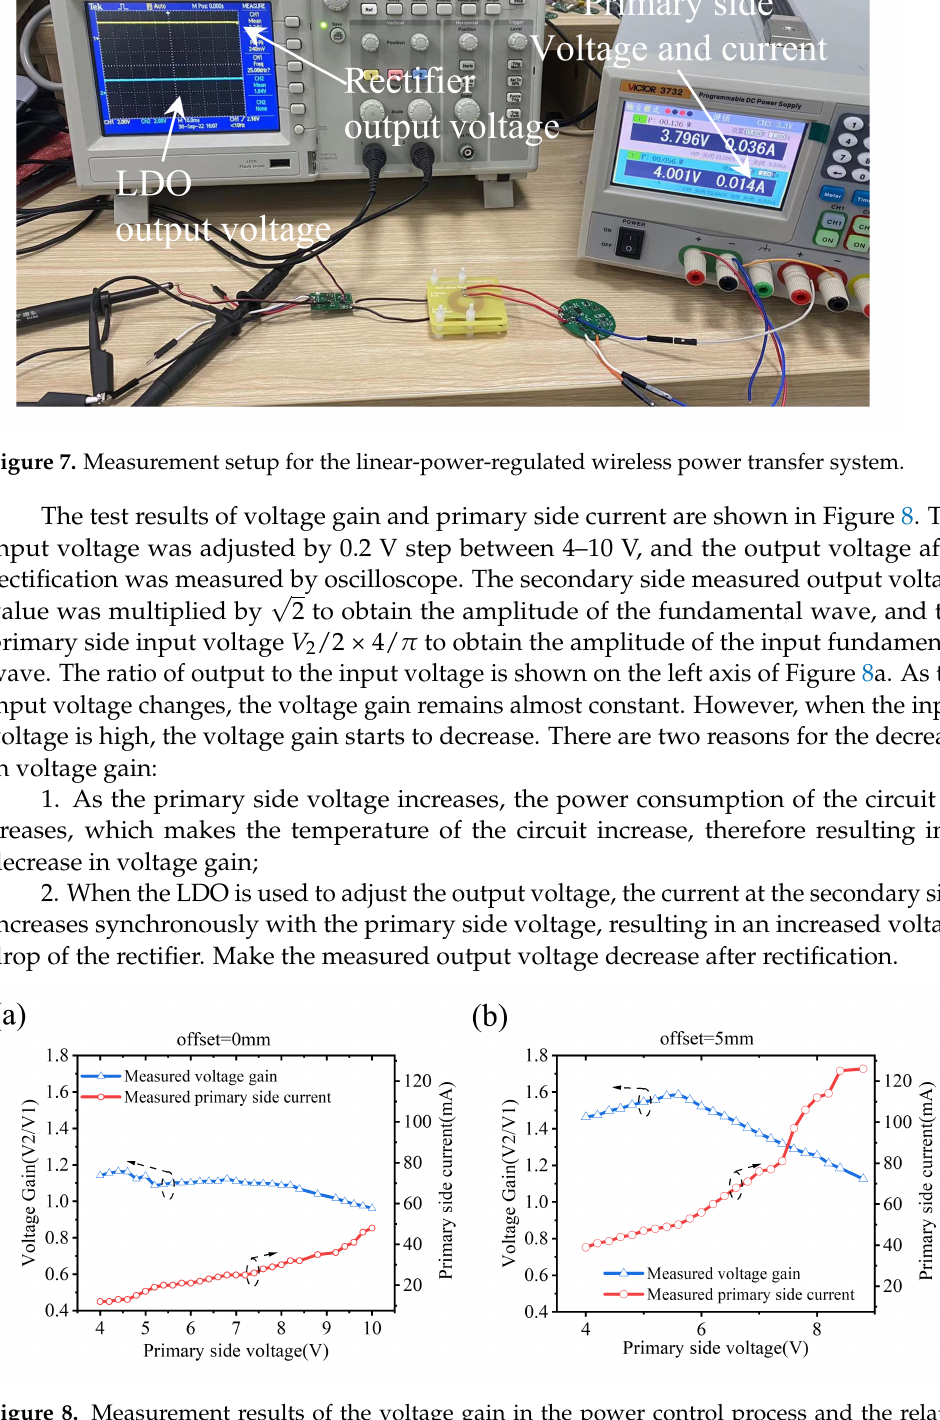
Figure 8. Measurement results of the voltage gain in the power control process and the related primary side current. ( a ) Coils with 5 mm intervals and perfectly aligned, ( b ) Coils with 5 mm intervals and with 5 mm